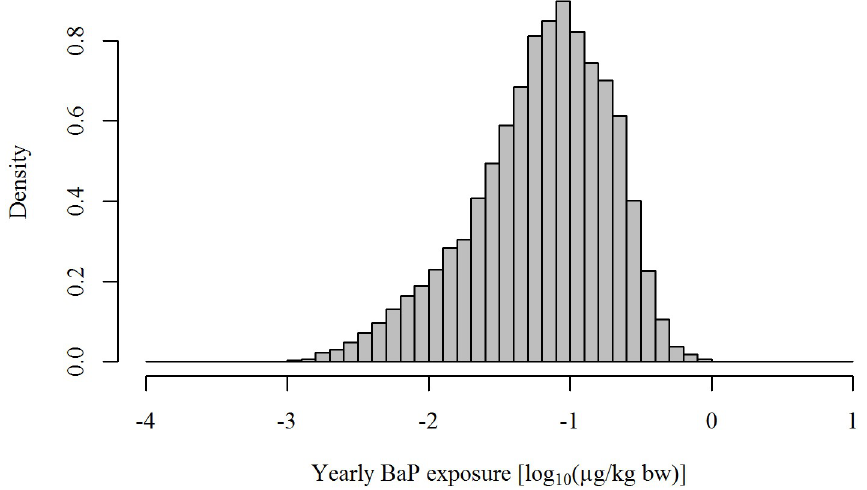
Fig 4. Population exposure to benzo[ a ]pyrene (in μ g/kgbodyweight/year) from barbecued meat on the log 10 scale.